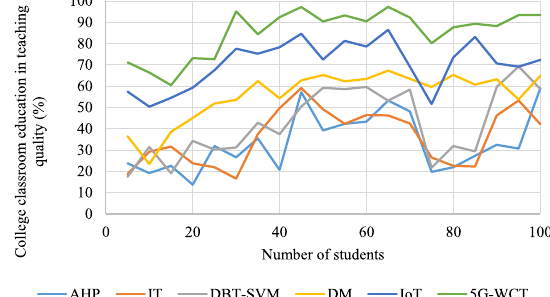
Fig. 9 Comparative Analyzes of college classroom education in quality